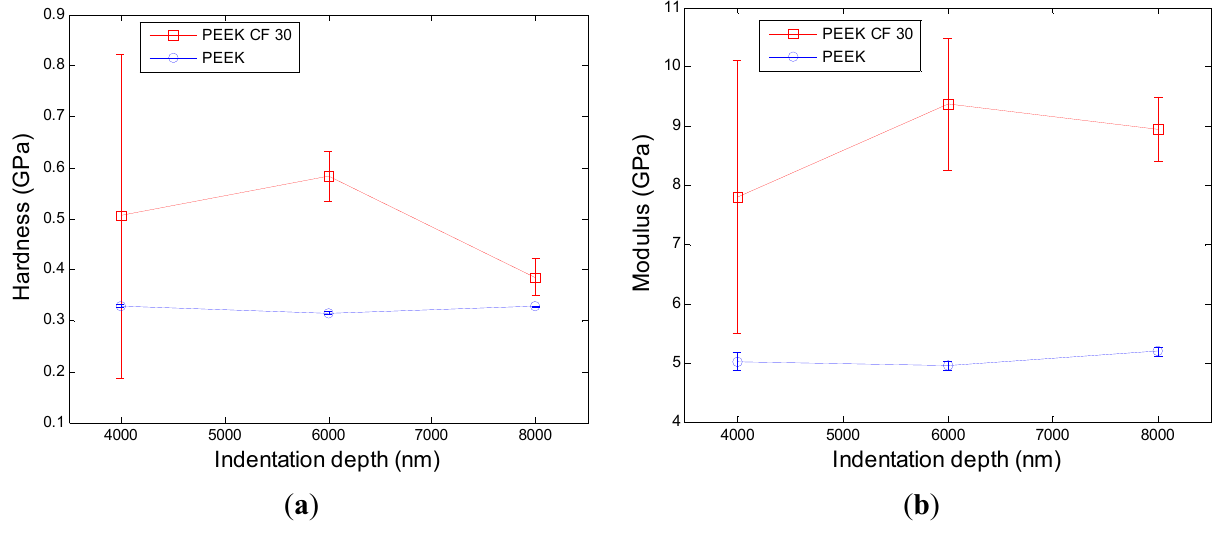
Figure 8. Hardness and Modulus at max load in different depth. ( a ) the hardness and ( b ) the modulus for